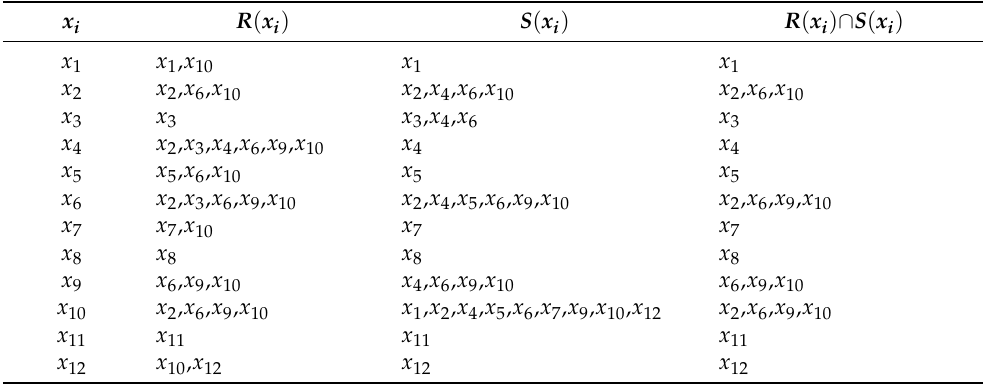
Table 7. Results of the first-level